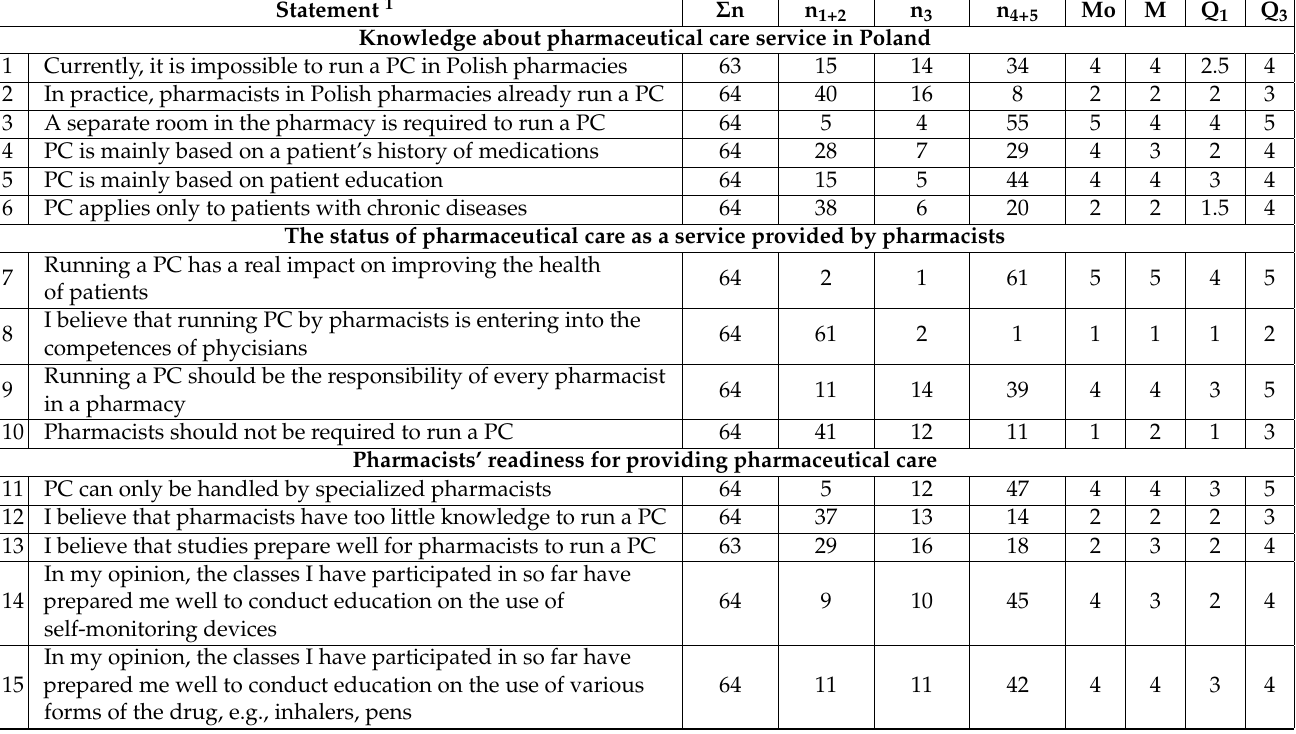
Table 4. Students’ knowledge and attitudes toward pharmaceutical